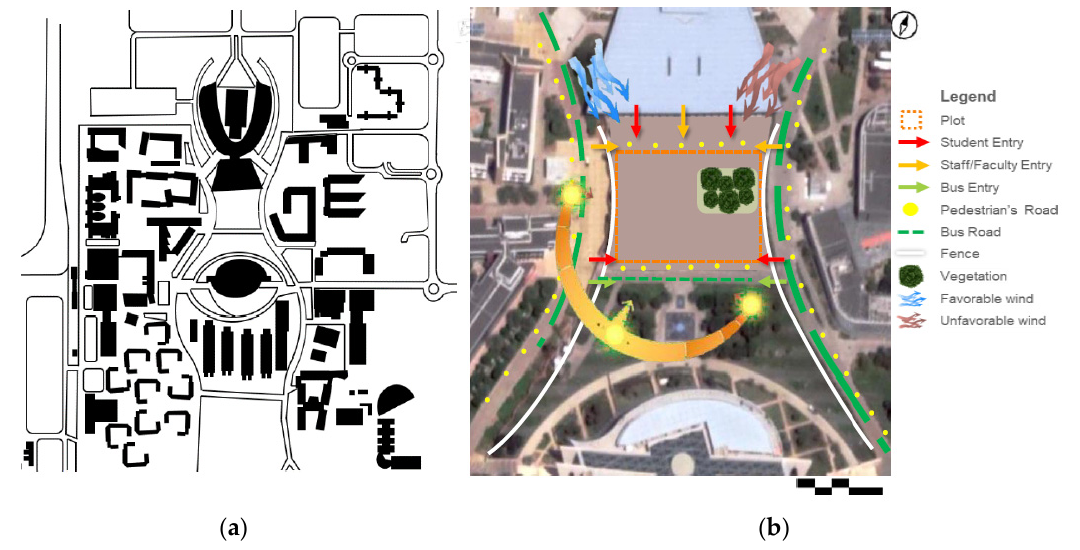
Figure 2. Site analysis ( a ) city level, ( b ) neighborhood level.